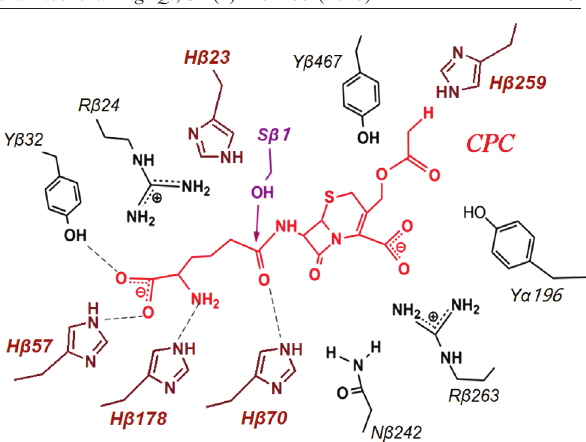
Fig. 4 – Schematic diagram of the hydrogen-bond network in the CCA-CPC complex within 4 Å in the catalytic sites. The arrow indicates the position of the site of cephalosporin C (red) hydrolysis with respect to the OH-group of Sβ1 (purple). The histidine residues in the substrate-binding cavity are bolded (brown). The other residues close to the substrate in the cata- lytic sites are in black. The dashed lines represent hydrogen bonds. Distances are not represented to